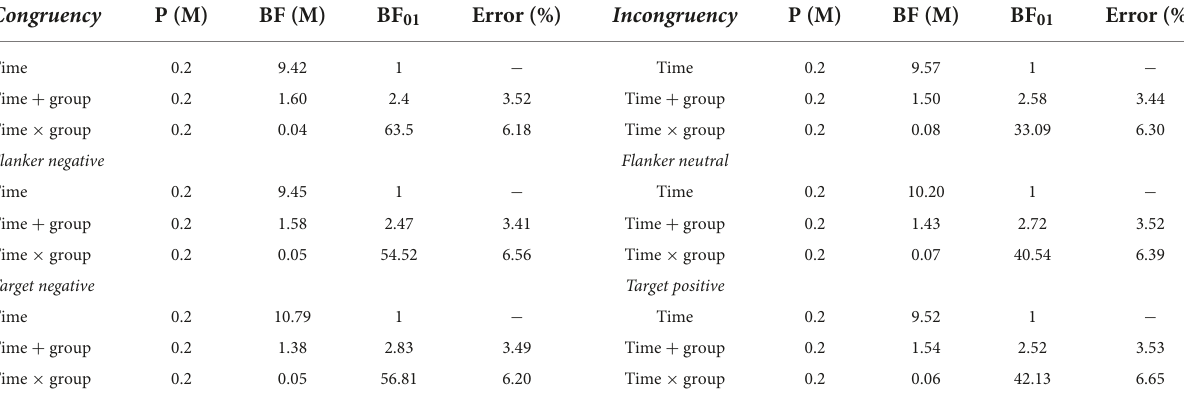
TABLE 3 Results of Bayesian analysis for each cognitive and valence domain: Repeated measures Bayesian analyses show moderate to strong evidence for the null hypothesis when considering the group and group by time interaction terms for each cognitive and valence-dependent